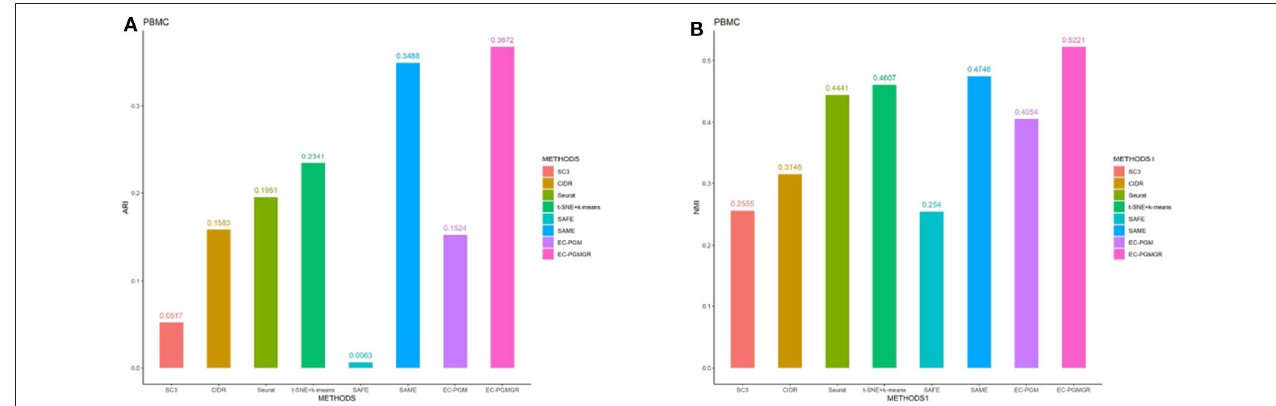
FIGURE 7 | The performance with different methods on PBMC data set. (A) The ARI performance. (B) The NMI performance.